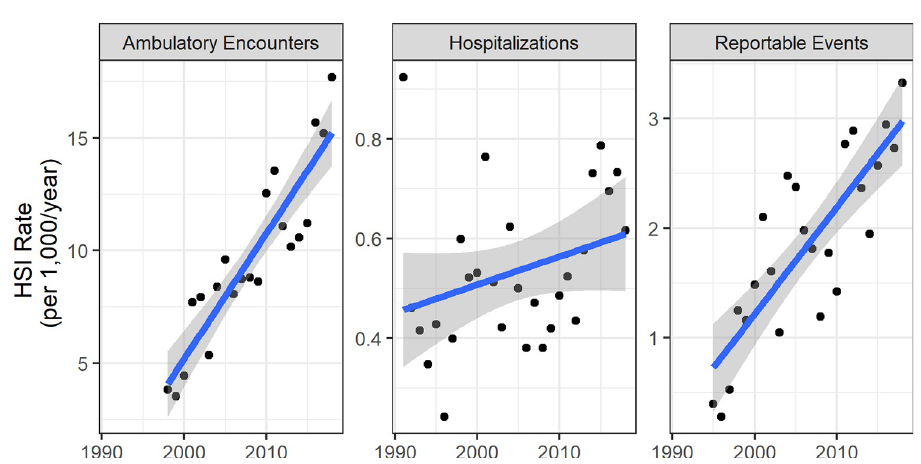
Fig 2. Combined HSI outcome rates for ten CONUS Army installations. The line represents a linear model and the shaded area models 95% confidence levels. Note that the scales vary by outcome category by orders of magnitude.